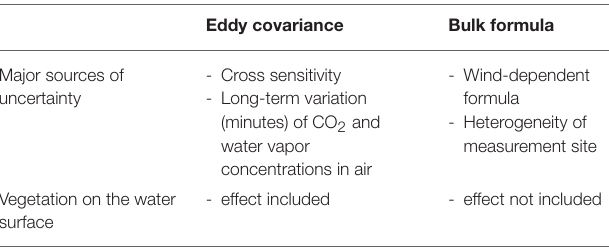
TABLE 1 | Summary of the differences in fluxes calculated by the eddy covariance and bulk formula